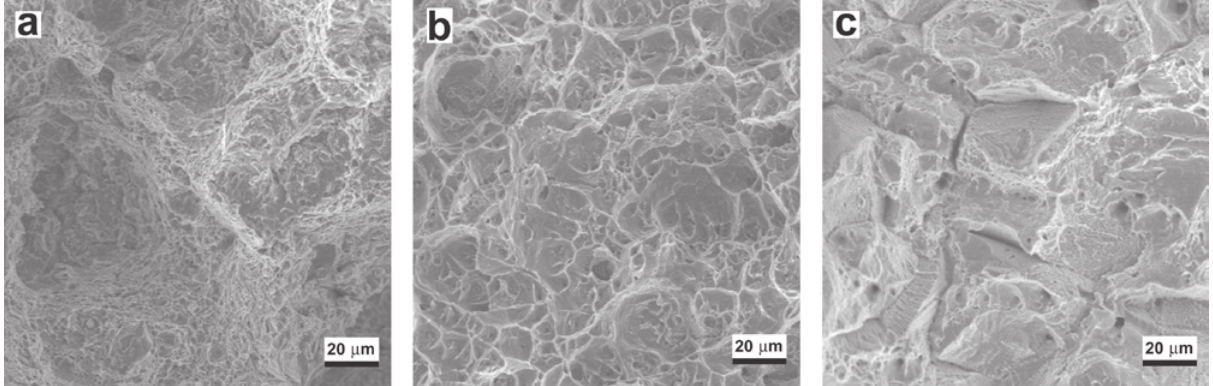
Fig. 8: SEM-fractographs of different regions of the T91/TP316H weldment in thermally exposed state at 600 °C/1000 h after room- temperature tensile testing with hydrogen charging: T91 steel HAZ (a), Ni WM Thermanit Nicro 82 (b), TP316H steel HAZ